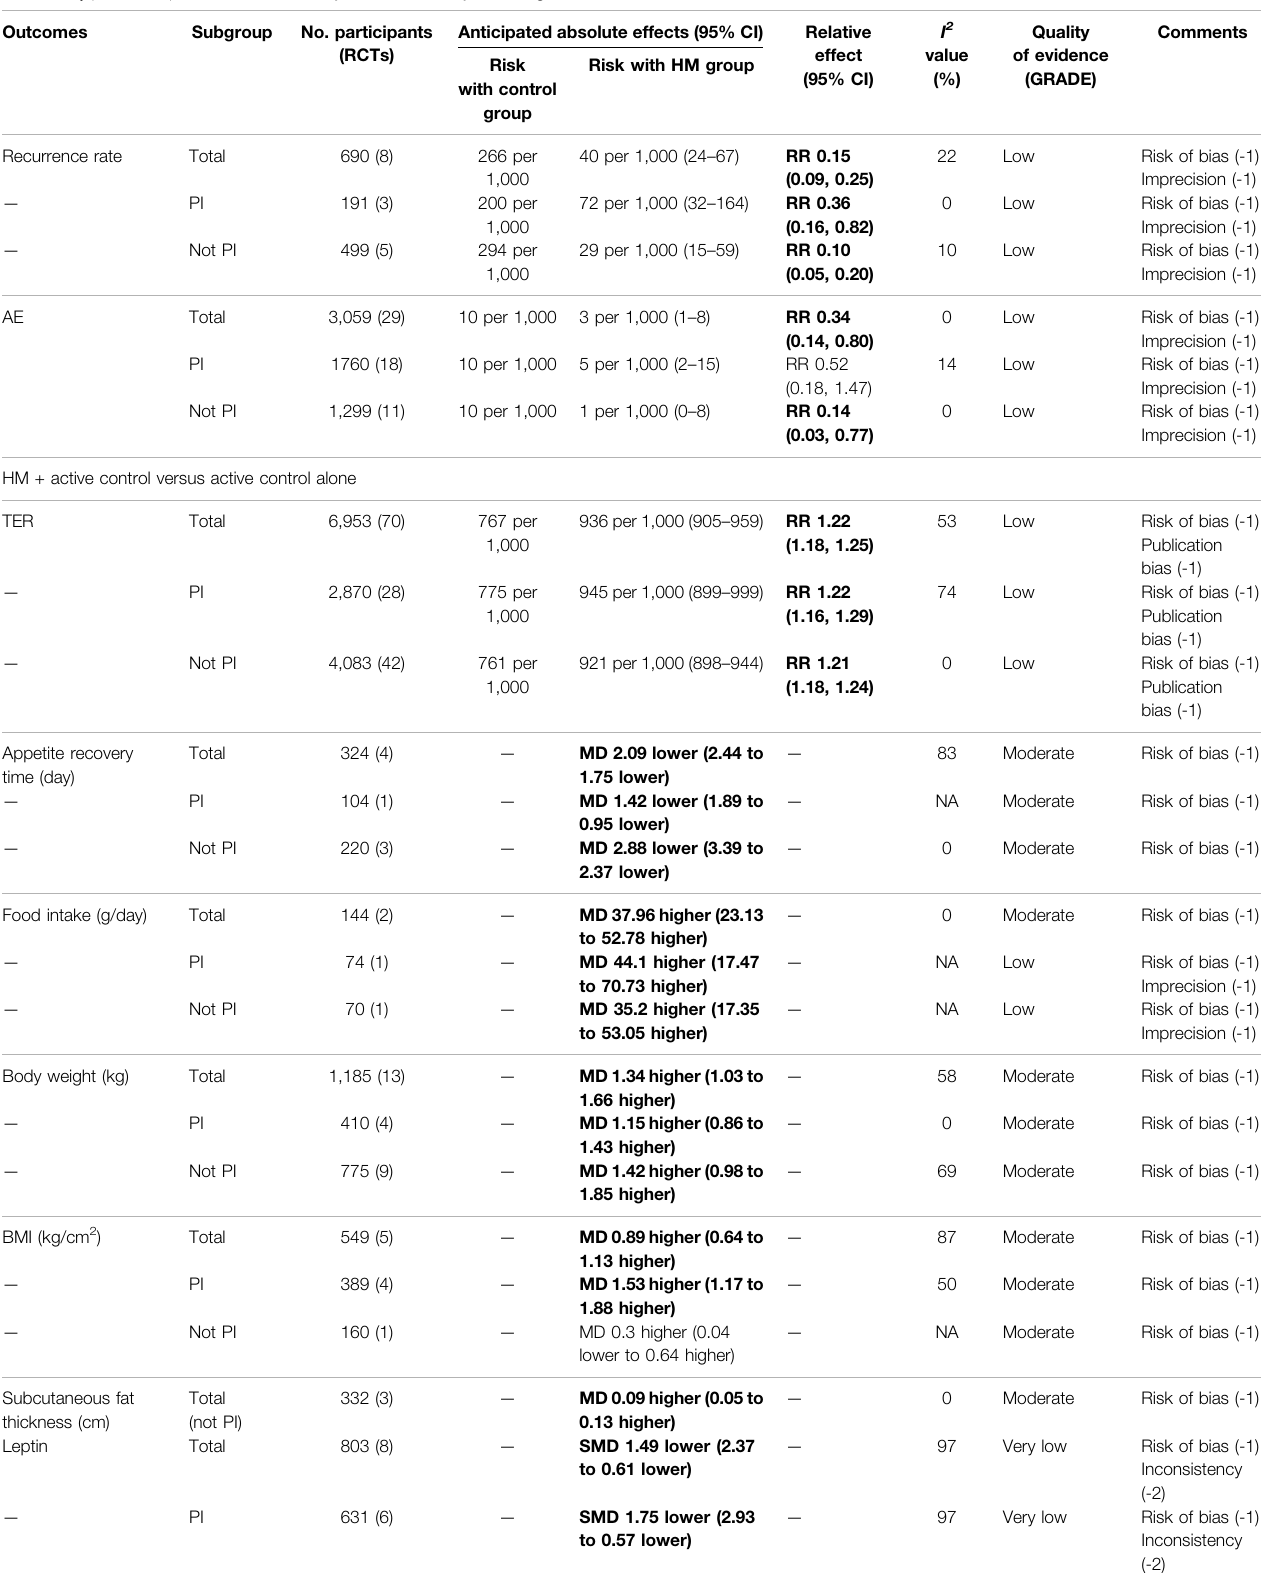
TABLE 1 | ( Continued ) Results of meta-analysis and summary of fi